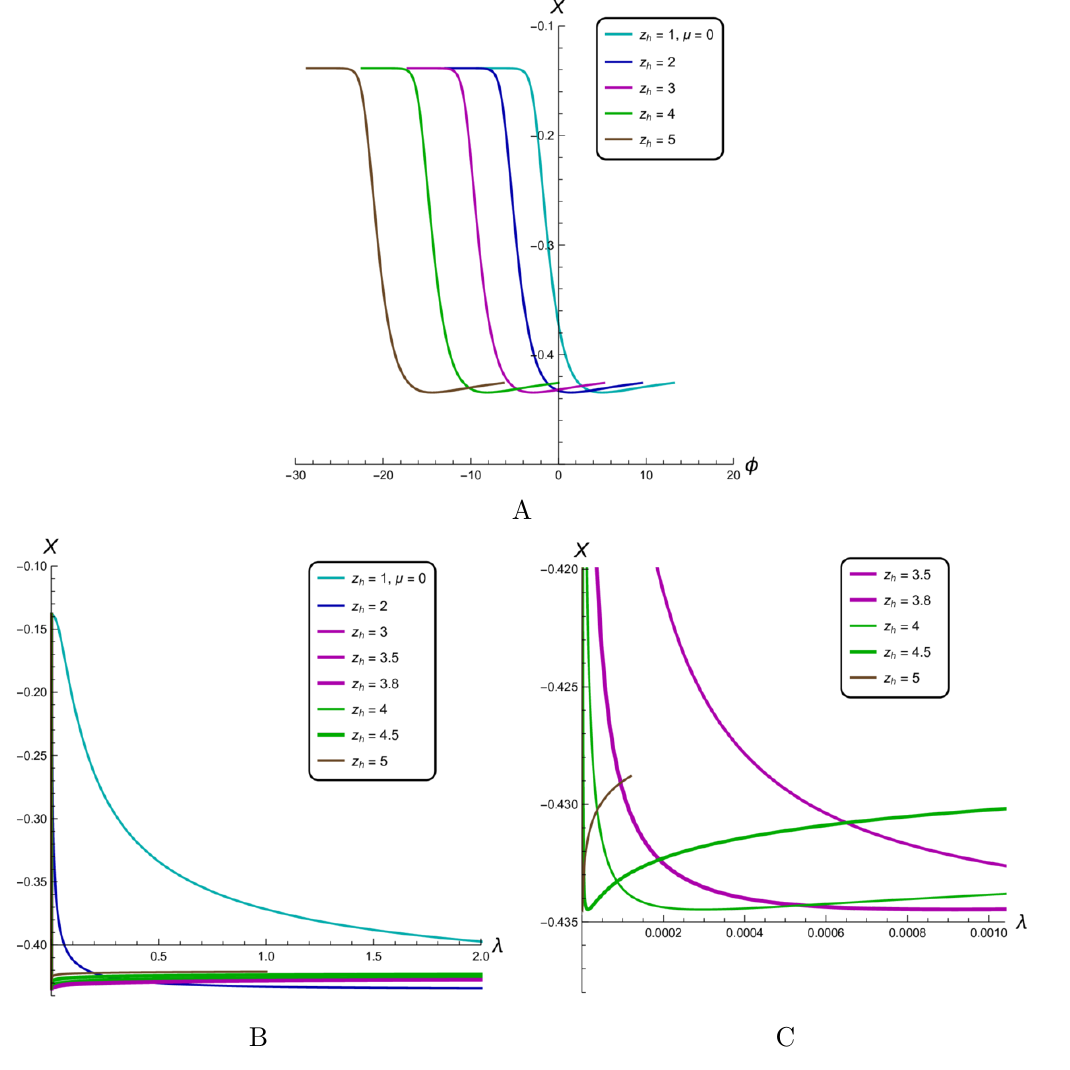
Figure 12 . The RG (cid:13)ows for anisotropic case (cid:23) = 4 : 5 and di(cid:11)erent z h in the ( (cid:30); X )-plane (A), in the ( (cid:21); X )-plane (B) and in a small part of (B) near the origin (C). the same horizon values are shown. We see, that for both cases (cid:12) ( (cid:21) ) < 0 in an agreement with the asymptotical freedom. For larger z both functions display more non-linearity and h decrease faster with the argument grow. This tendency is peculiar either for the isotropic or the anisotropic case. The only special di(cid:11)erence is the non-zero value of (cid:12) (0) for (cid:23) = 1. We expect that changing the form of P ( z ) we can, as in the isotropic case [5, 40, 58], to recover the (cid:12)rst orders expression of the perturbative (cid:12) -function. In (cid:12)gure 14 we show the dependence of the (cid:12) -function on H for the isotropic and anisotropic ( (cid:23) = 4 : 5) cases. We see that (cid:12) is the increasing function of H , approximately linear for large negative argument values and displaying its non-linearity near zero. The function values are visibly larger for larger chemical potential, while the anisotropy does not change this picture much.